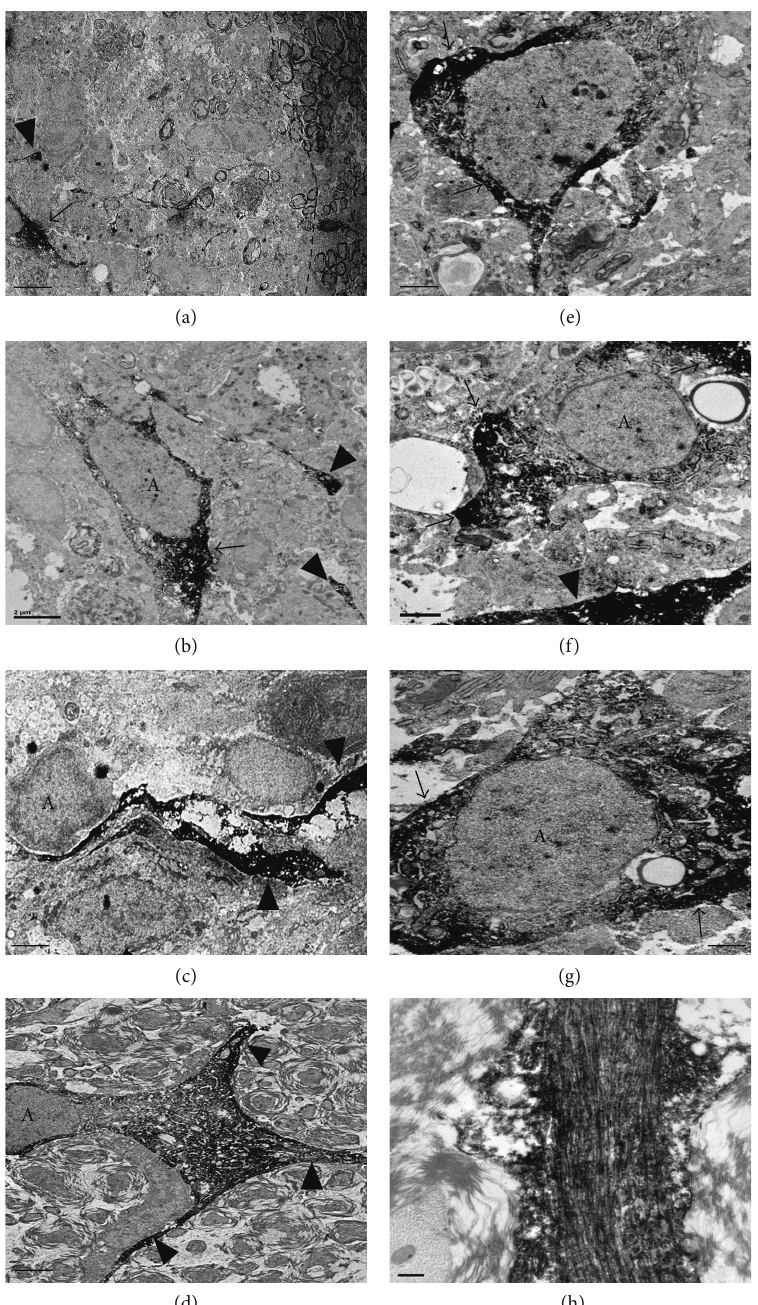
Figure 2: Localization of GFAP-immunoreactivity by immunoelectron microscopy within the region of immunological demyelination 7 days following intraspinal injection of GalC antibodies plus complement proteins. (a) Lower magnification of (b) showing a GFAP-positive astrocyte and the nearby border zone between the normally myelinated and demyelinated region (hatched line). Note the lack of astrogliosis at the border zone. (b)–(g) Astrocyte (A) with GFAP-immunoreactivity (arrows) within the cytoplasmic compartment immediately adjacent to the nucleus and a GFAP-positive process (arrowhead). For comparison, (d) illustrates distal reactive astrocytes 1mm rostral to the injury epicenter. Note the hypertrophied process and multiple branches (arrowheads). (h) High magnification with focus on GFAP-positive process (black ∗ ). Note multiple dark GFAP-positive parallel lines corresponding to intermediate filaments. Scale bars: (a) 5 𝜇 m; (b), (c), and (f) 2 𝜇 m; (d) 5 𝜇 m; (e) and (g) 1 𝜇 m; (h) 0,2 𝜇